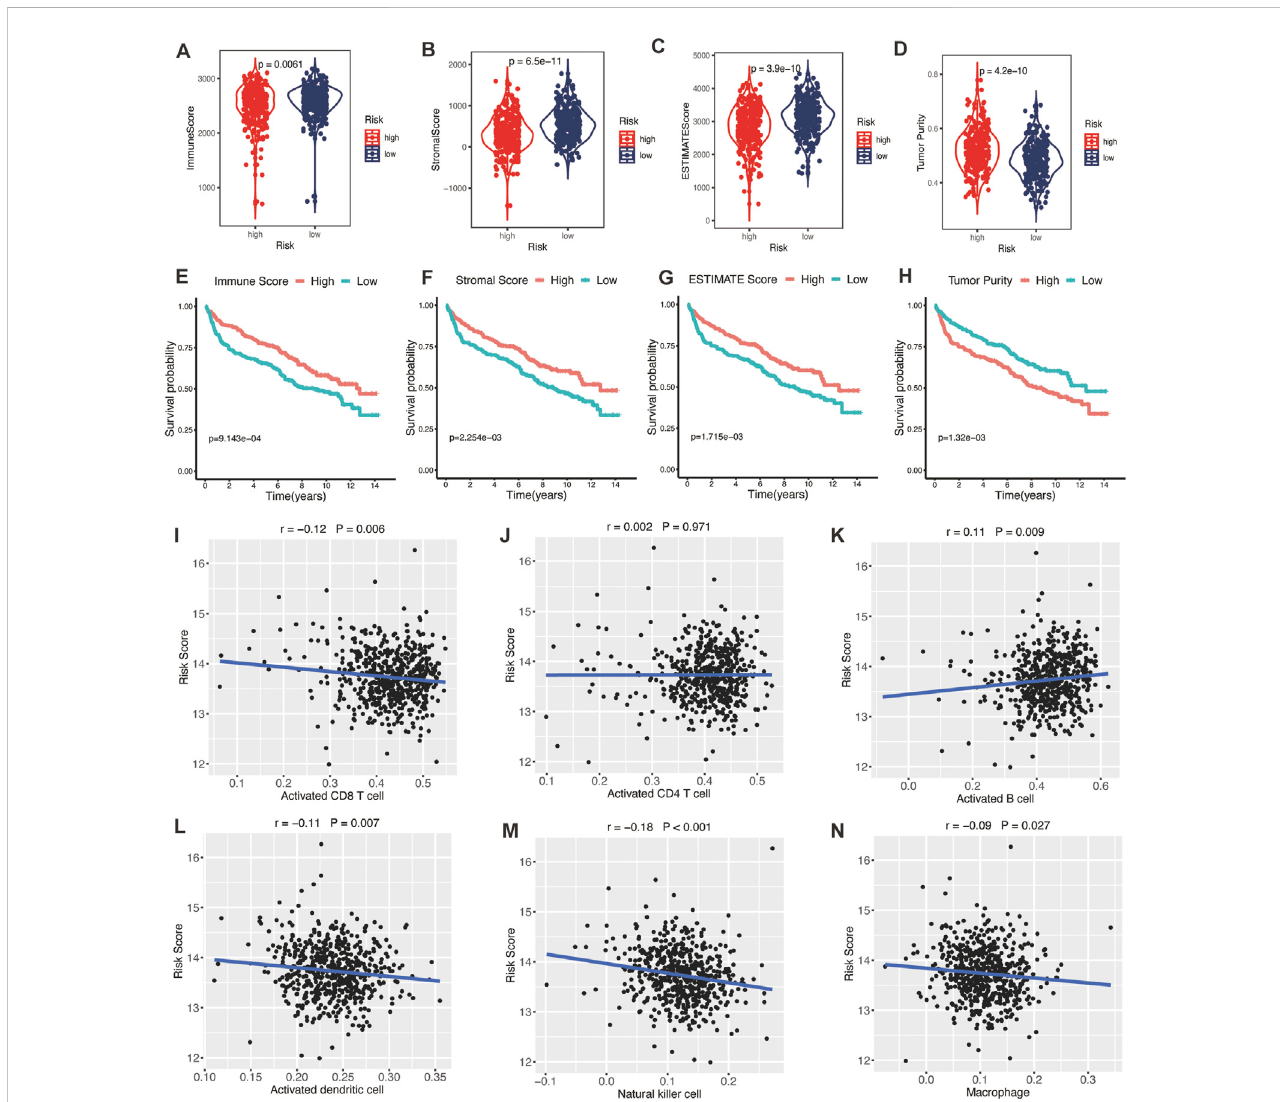
FIGURE 7 Association between glycolytic gene signature and tumor microenvironment. (A – D) Comparison of the immune score, stromal score, ESTIMATE score, and tumor purity between low- and high-risk patients with DLBCL. Kaplan-Meier analyses of high- and low-immune score (E) , stromal score (F) , ESTIMATE score (G) , and tumor purity (H) patients. Correlation between activated CD8 T cells (I) , activated CD4 T cells (J) , activated B cells (K) , activated dendritic cells (L) , natural killer cells (M) , macrophages (N) , and risk score. DLBCL, diffuse large B-cell